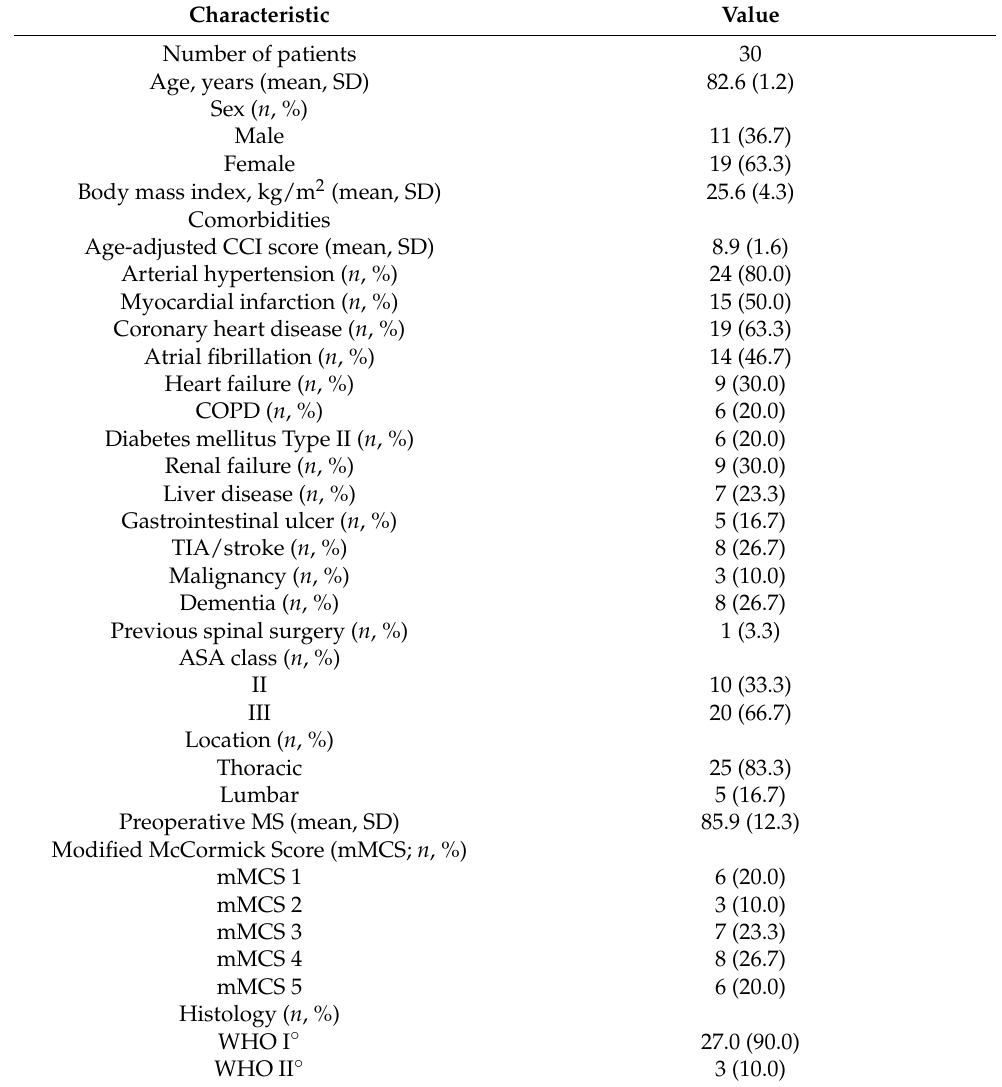
Table 1. Baseline